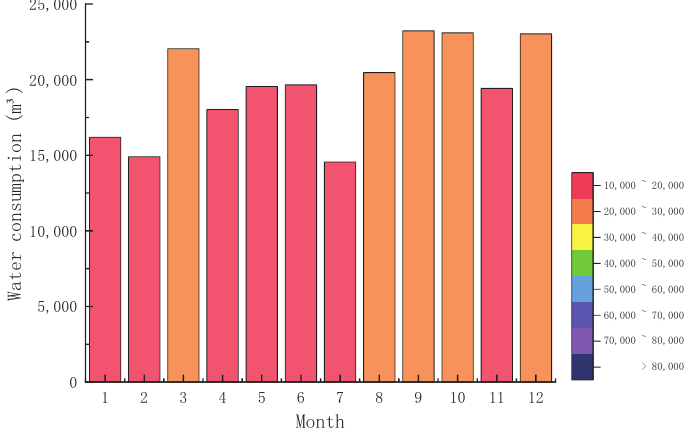
Figure 7. Bar chart of water consumption in mining